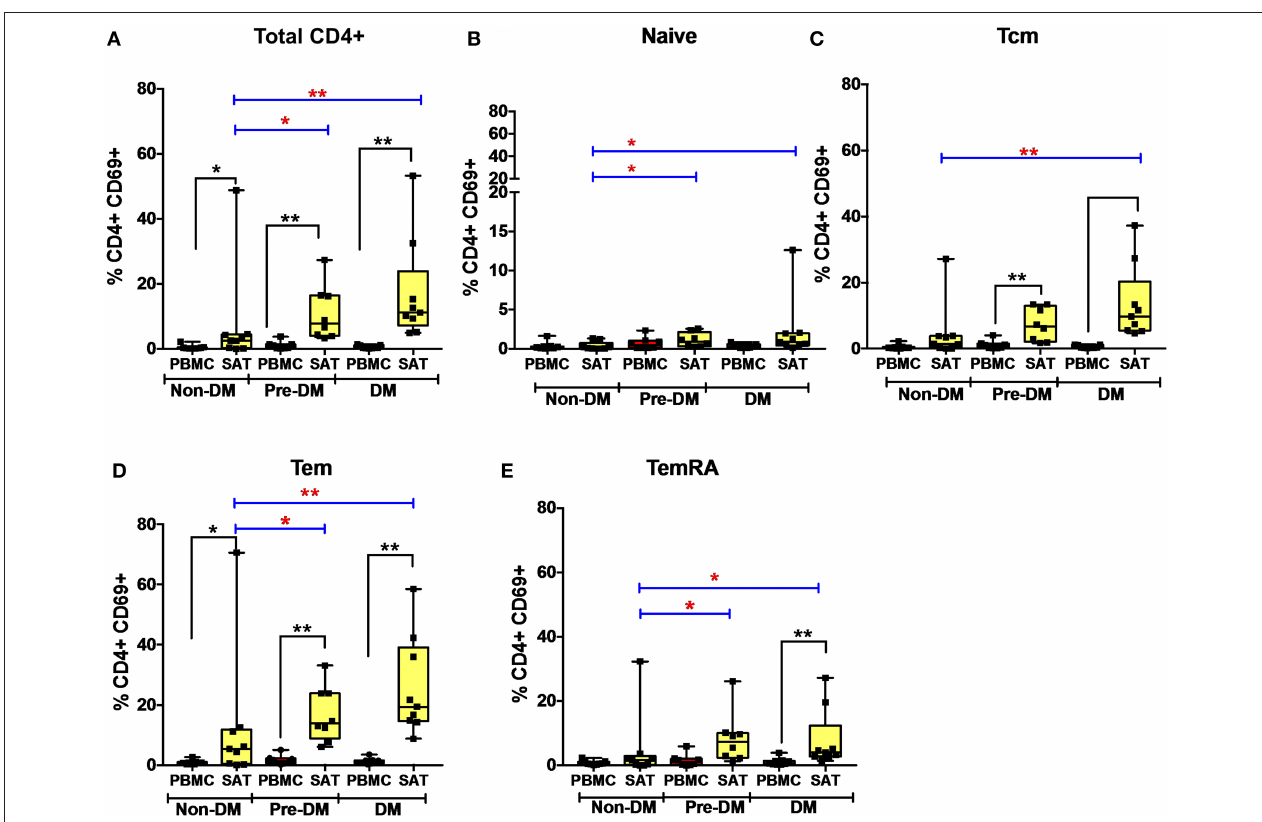
FIGURE 4 | CD69 expression on subcutaneous adipose tissue CD4 + T cells increases with progressive glucose intolerance. (A–E) Frequencies of CD4 + total T cells, T Nai , T CM , T EM , and T EMRA cells expressing the CD69 activation and putative tissue-residence marker in subcutaneous adipose tissue (SAT) and blood (PBMC). The box and whiskers plot indicate mean ± SD. Wilcoxon matched-pair rank test was used to calculate differences between PBMC and SAT. Mann-Whitney test used to calculate differences between groups; blue lines and red * depict differences between groups ** p < 0.01, * p <